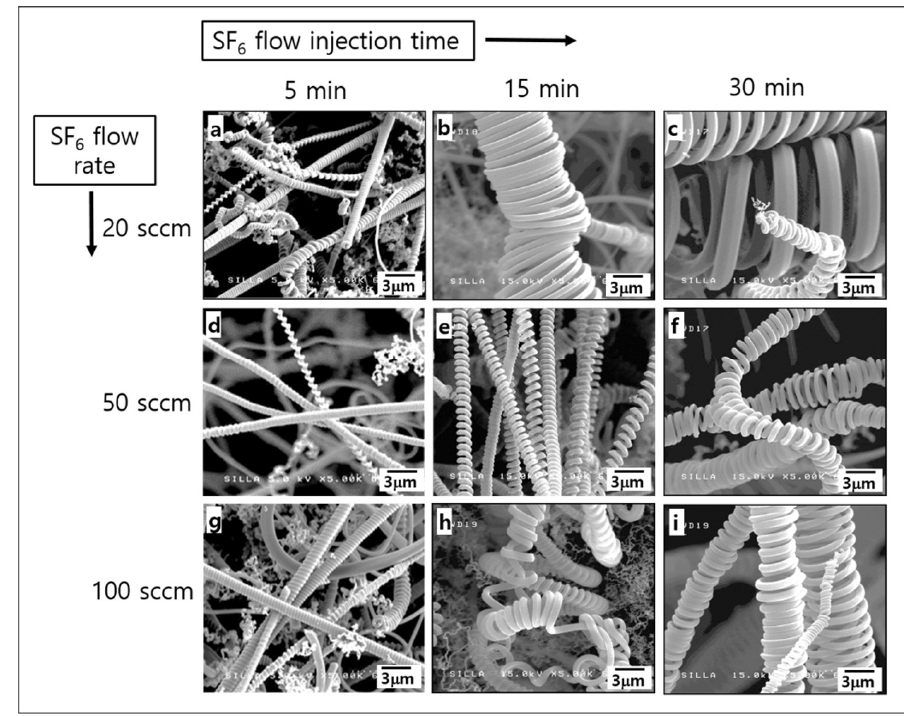
Figure 1. The FESEM images of the surface morphologies for samples ( a ) A, ( b ) B, ( c ) C, ( d ) D, ( e ) E, ( f ) F, ( g ) G, ( h ) H, and ( i ) I. ( f ) F, ( g ) G, ( h ) H, and ( i )